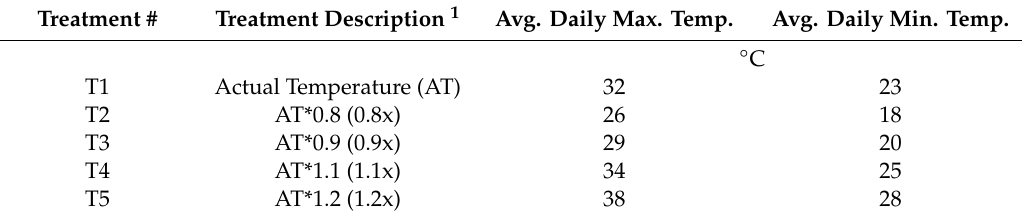
Table 7. Simulated maximum (daytime)